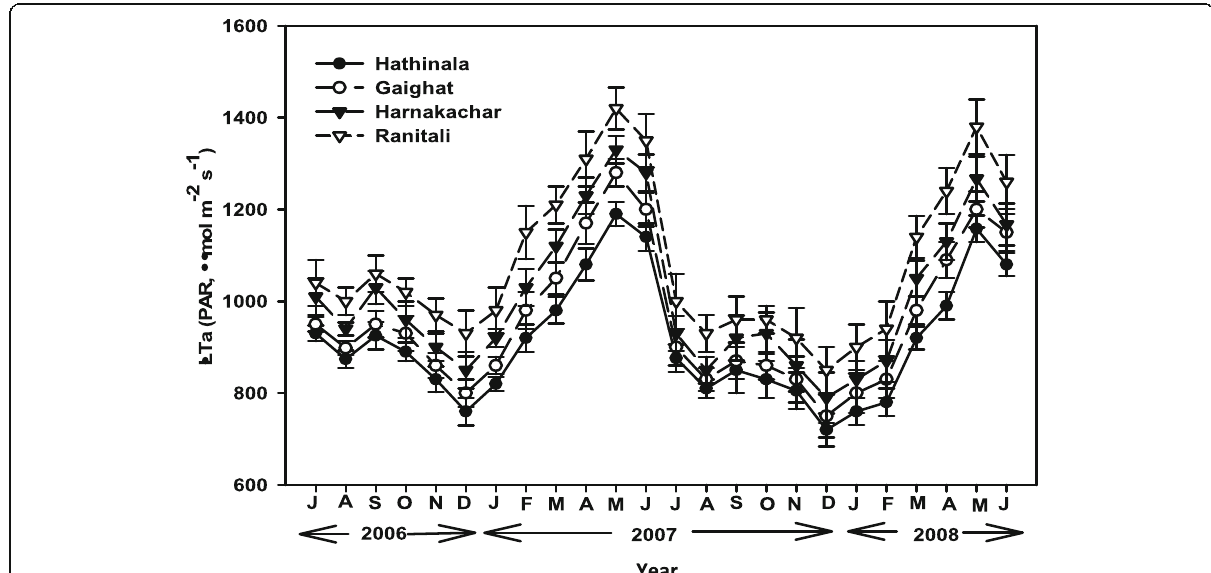
Fig. 2 Variation in the availability of light (LTa, PAR; mean and S.E.) across seasons, sites, and canopy conditions measured for a period of 2